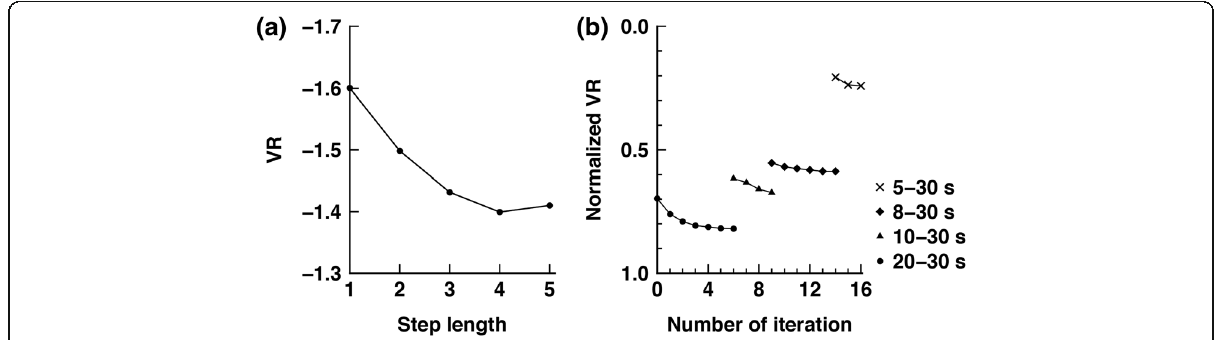
Fig. 7 Waveform fitting in the inversion process. a Step length search in the first iteration. b Waveform misfit between the observed and synthetic waveforms in each iteration. The fitting value is normalized by the fitting value of the first iteration of each period band. The period band used in each iteration is also